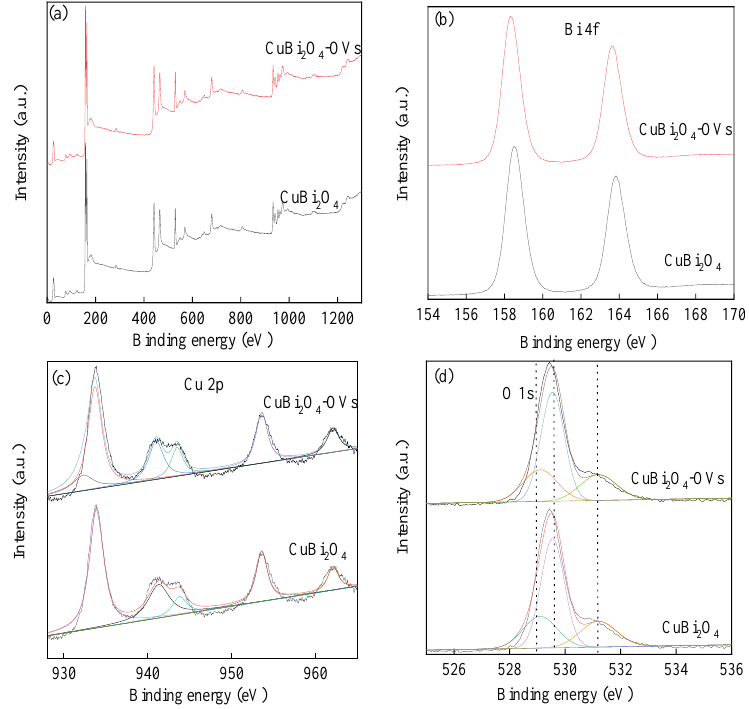
Figure 4. X-ray photoelectron spectroscopy (XPS) spectra of as-prepared catalysts. ( a ) full-scale XPS spectra, ( b ) Bi 4f, ( c ) Cu 2p, and ( d ) O 1s.